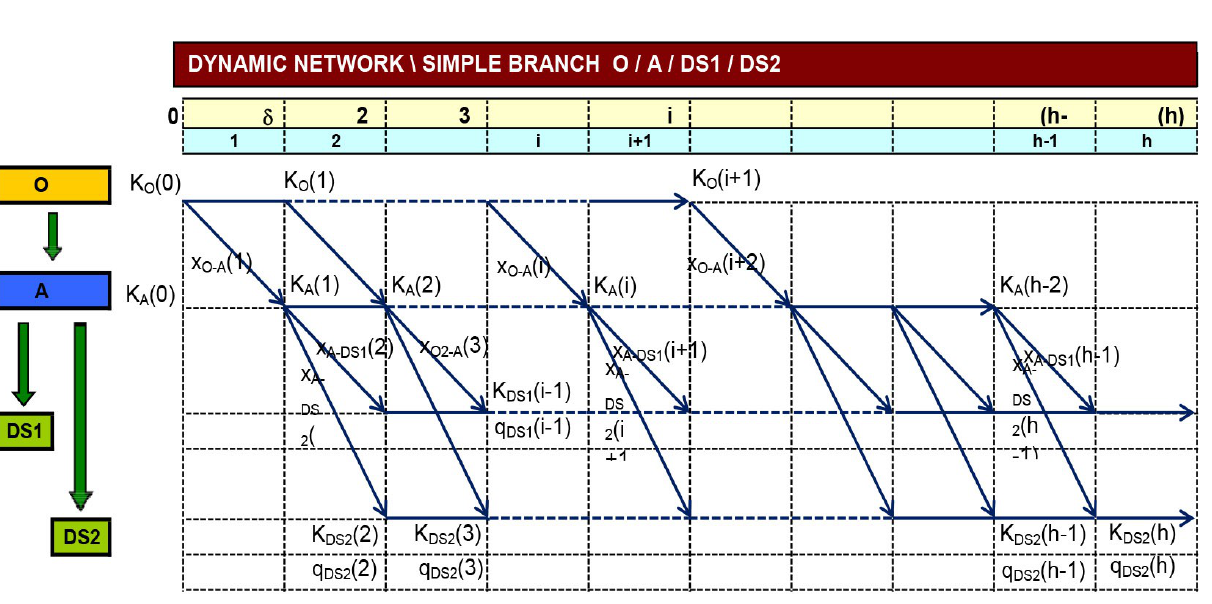
Figure 22. Values of a simple branch dynamic